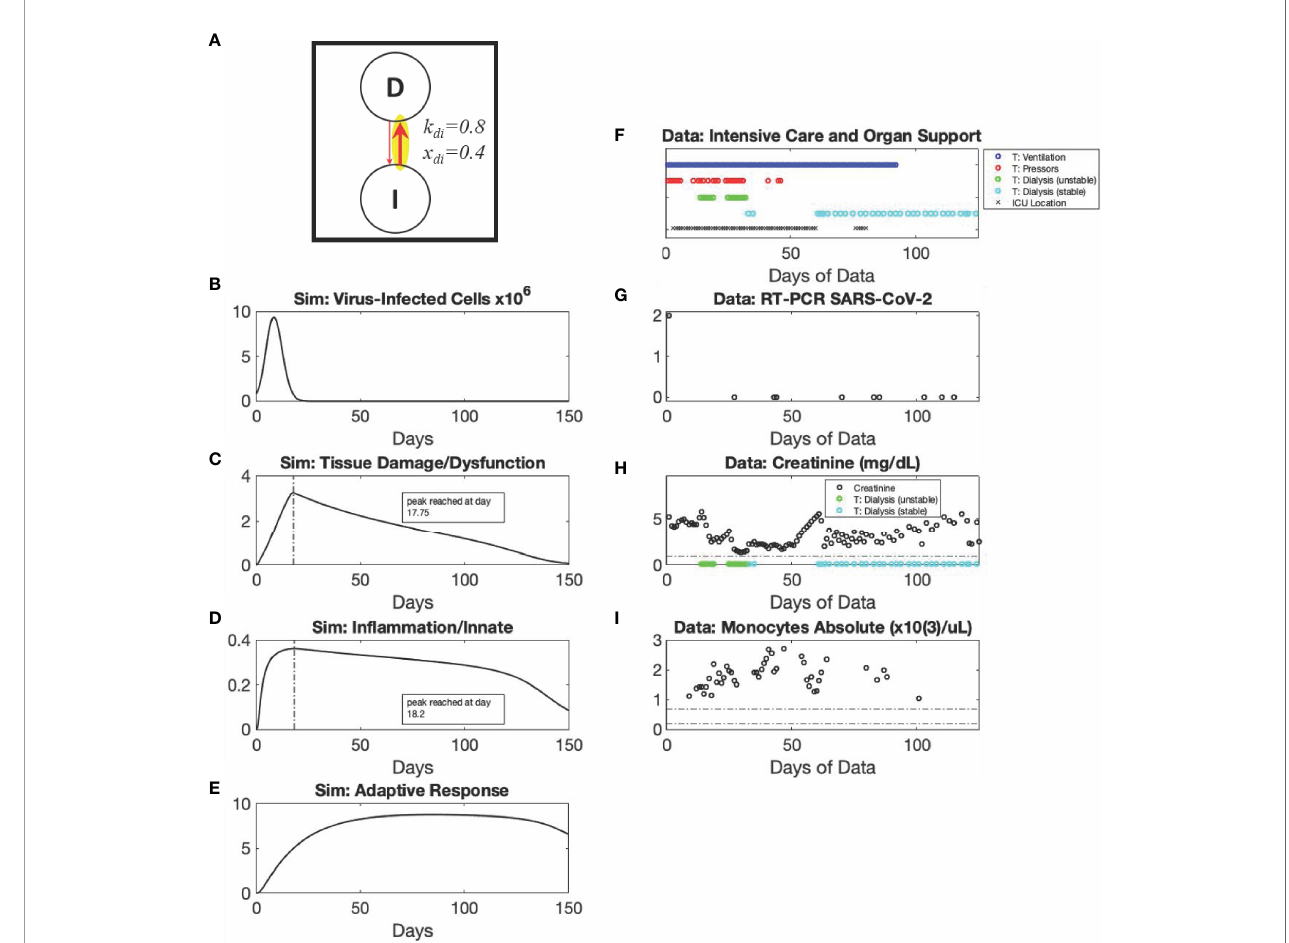
FIGURE 4 | Recovery archetype, Severe scenario: simulation vs. patient data. Using modi fi ed values of parameters k di and x di compared to Mild scenario as shown in the diagram (Panel A ), simulated dynamics are shown of C V (Panel B ) (Initialized with a C V =8x10 5 virus-infected cells), D (Panel C ), I (Panel D ), and A (Panel E ). Panels (F – I) show data from a patient in their 50s with diabetes who presented with COVID-19 acute respiratory distress syndrome. The patient was most critically ill from hospital day 14 to 32, requiring intermittent vasopressors and being unable to tolerate intermittent hemodialysis (instead requiring continuous venovenous dialysis). Despite being ventilator dependent until Hospital Day 93, the patient was able to leave the intensive care unit by Hospital Day 60. They were discharged to a skilled nursing facility on the 125 th day, tolerating a speaking valve (tracheostomy) with a strong voice and walking with assistance but still requiring